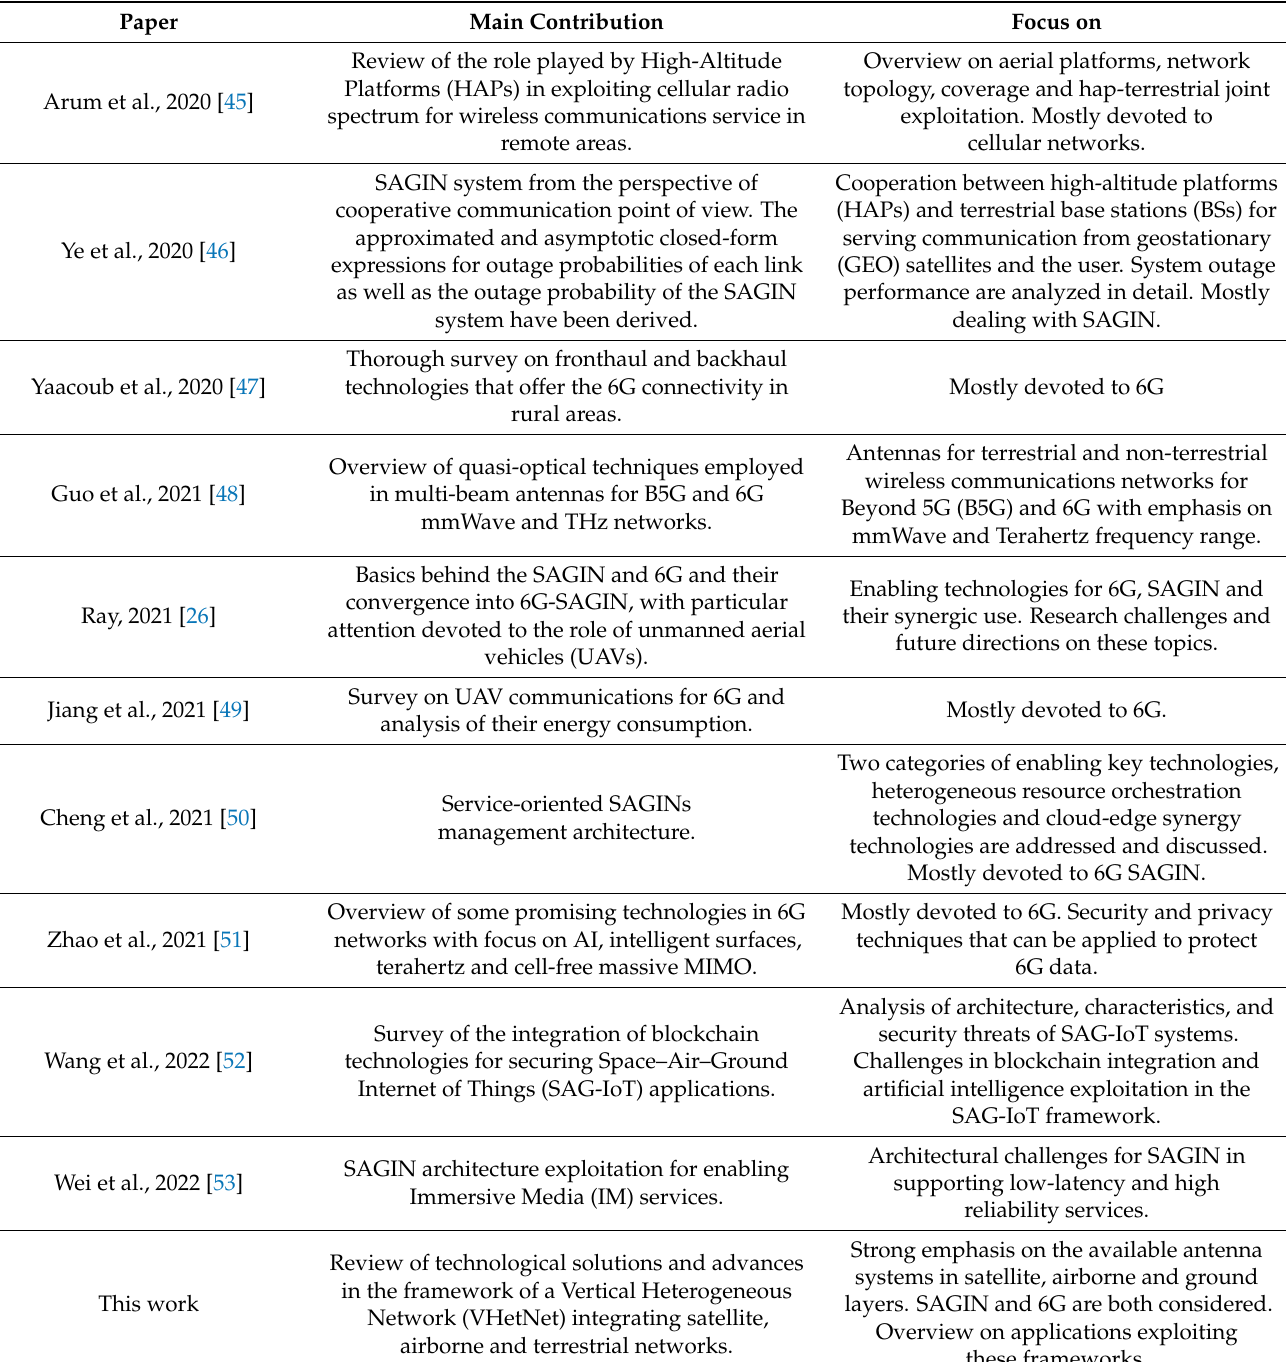
Table 1. An overview of survey papers dealing with 6G and